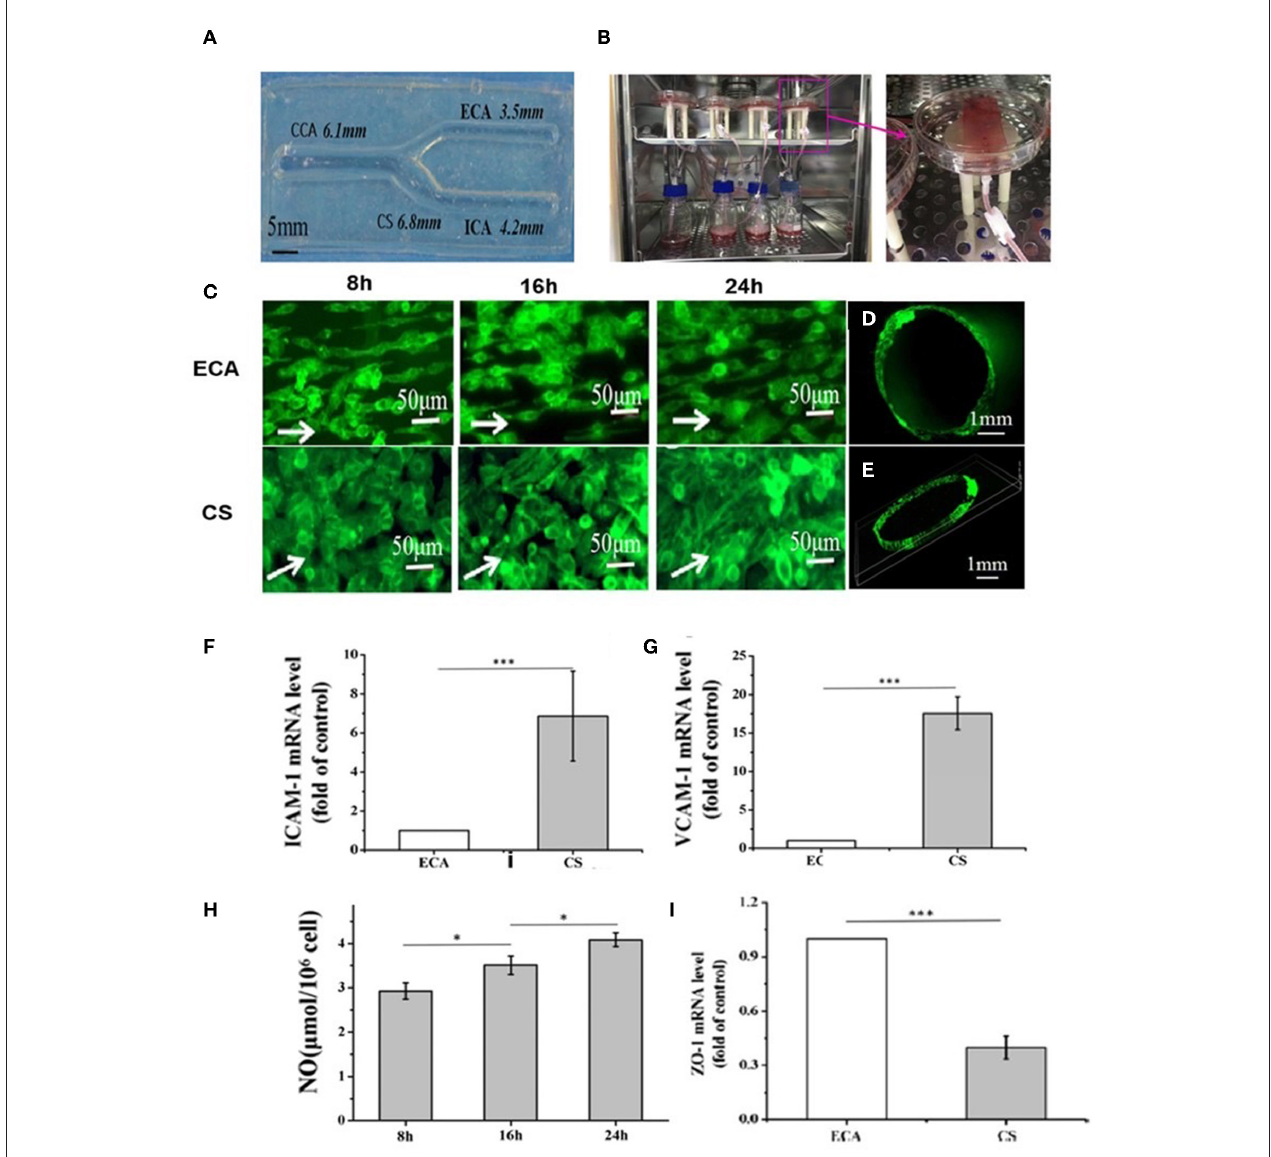
FIGURE 5 | (A) Gelatin-based carotid artery model. (B) Actual assembled carotid artery system. (C) ECs morphology in Region ECA after dynamic experiment 8, 16, and 24h or ECs in Region ECA. ECs morphology in Region CS after dynamic experiment 8, 16, and 24h. (D,E) Distribution of ECs in cross-section of Region ECA (The white arrows point in the direction of flow). (F–I) The expression of ICAM-1 (F) and VCAM-1 (G) was studied in the Regions ECA and CS after 24-h perfusion experiment; (H) The vasoactive substances NO; (I) Expression of ZO-1 was studied in the Regions ECA and CS after 24h perfusion. Adapted, with permission from (183). * P < 0.05; *** P <